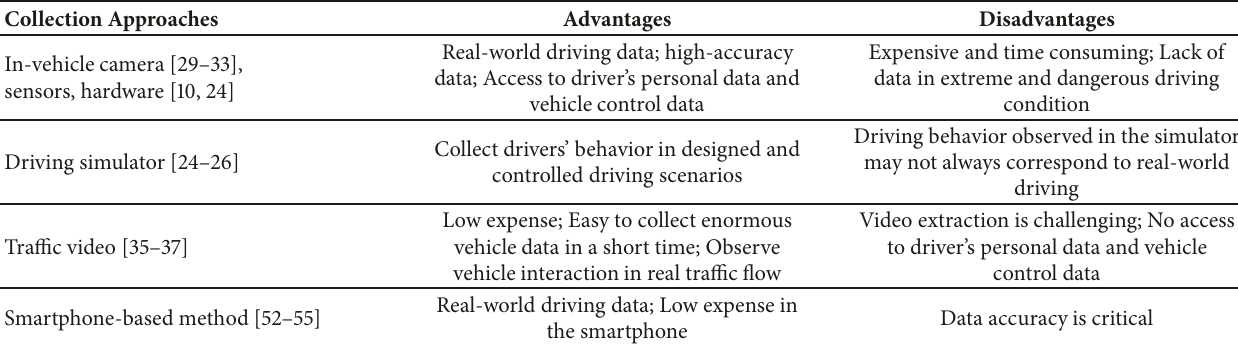
Table 1: Comparison of different driving behavior data collection